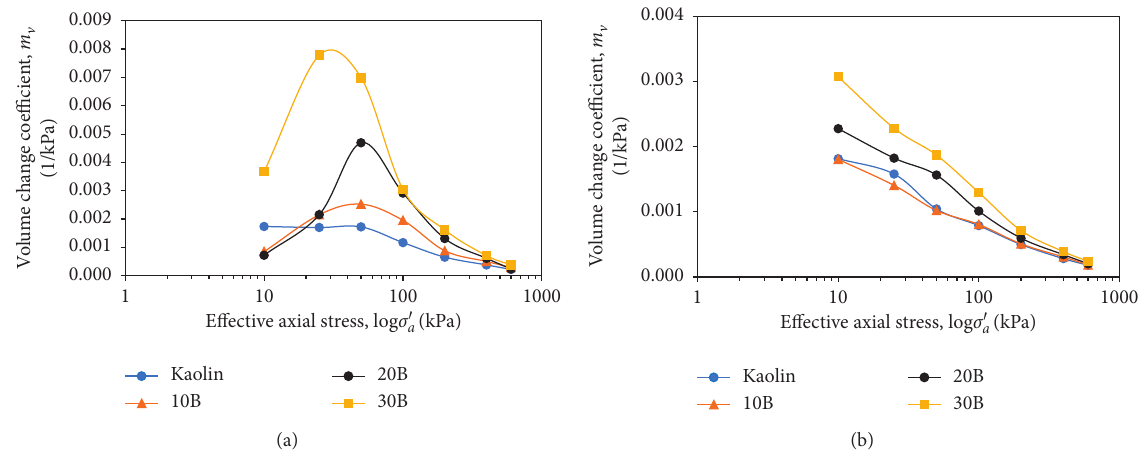
Figure 7: Variation of the coefficient of volume change ( m v ) with effective axial stress. (a) Distilled water; (b) 1M